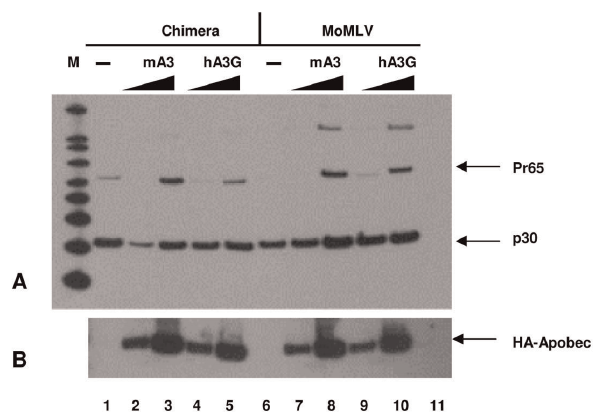
Figure 3. Immunoblotting of virus particles. A) Western blot on produced virus. Chimera (lanes 1 to 5) or MoMLV (lanes 6 to 10)